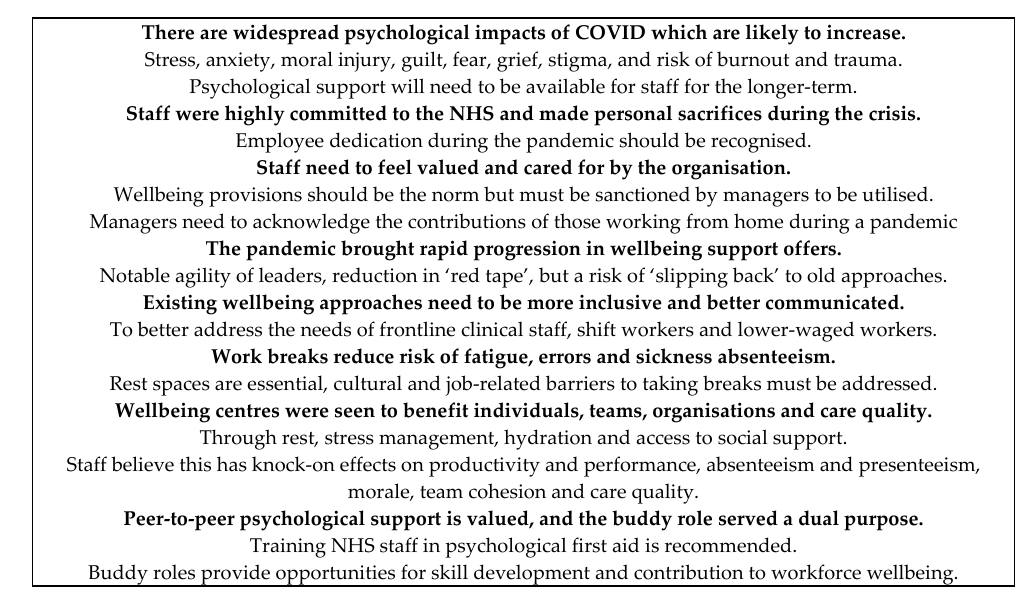
Figure 2. Key findings and interpretation.